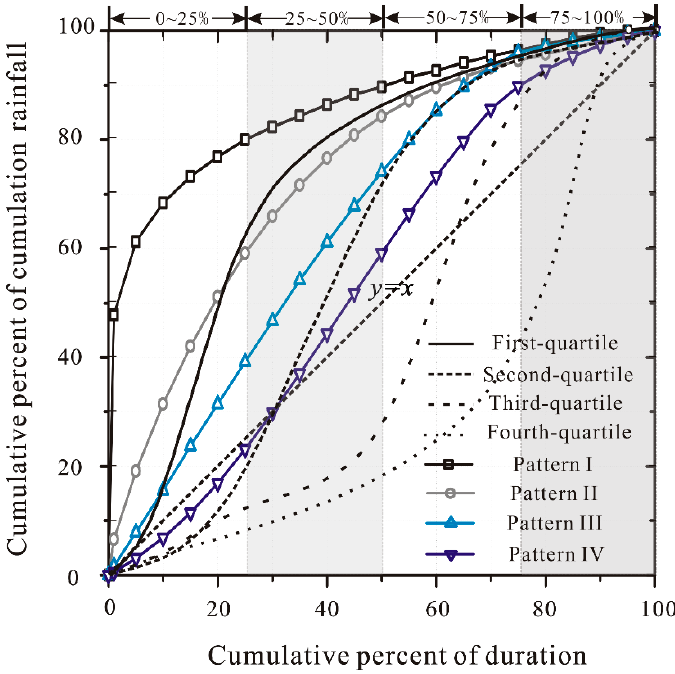
Figure 7. Typical curve of cumulative rainfall duration; first-quartile, second-quartile, third-quartile, and fourth-quartile stand for a 50% probability level for Huff curve, corresponding to four kinds of curves in the K-value clustering analysis of the data from the observation stations.